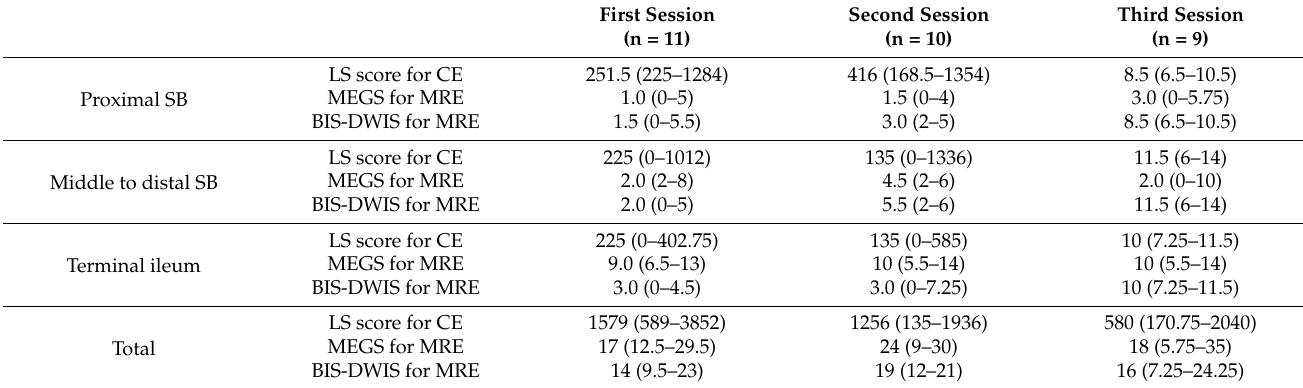
Table 2. Summary of scores obtained by magnetic resonance enterography (MRE) and capsule endoscopy (CE).